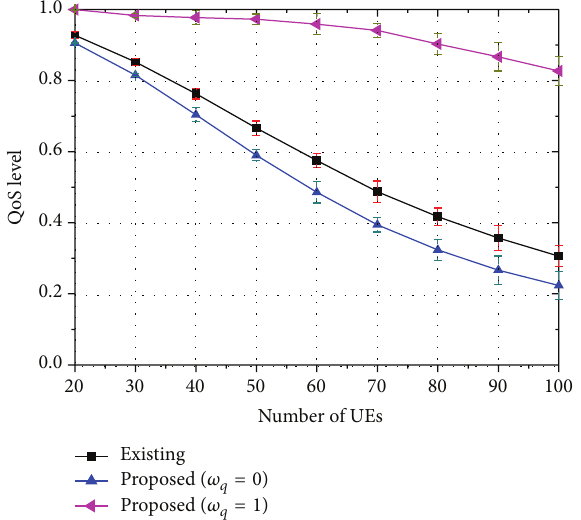
Figure 12: QoS level of 32-viewpoint 3D A/V traffic ( 𝛽 = 1.8